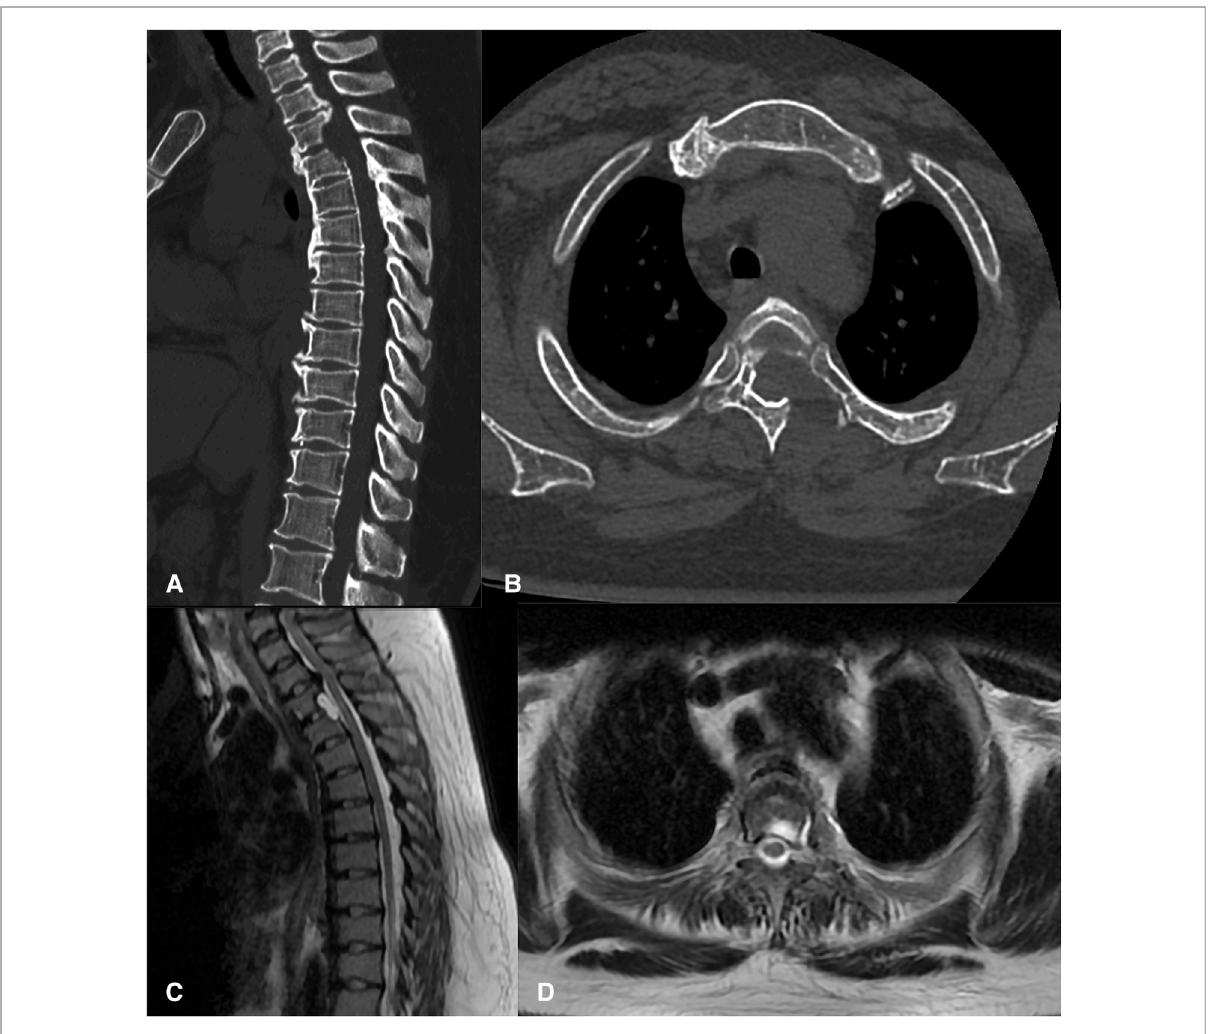
FIGURE 6 There was no evidence of instability or kyphosis on CT ( A,B ) and MRI ( C,D ) fi lms 6 months after surgery and the thoracic spinal cord was completely